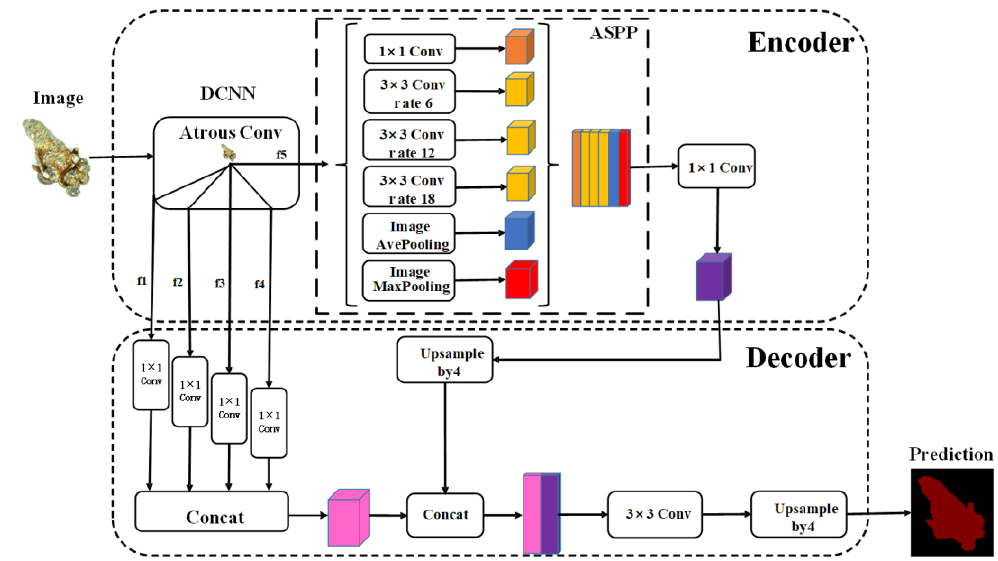
Figure 4. The network structure of the I-Xce-DeepLabv3+ model. Note: “Image” represents the original image, “Prediction” represents the predicted image, “DCNN” is the backbone feature extraction network, “Atrous Conv” is the atrous convolution, “f1, f2, f3, f4, f5” are the feature sizes output by the backbone feature network, and 1 × 1, 3 × 3 are the sizes of the convolution